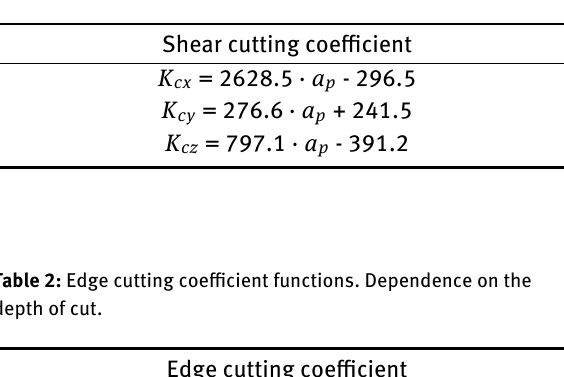
Table 1: Shear cutting coeflcient functions. Dependence on the depth of cut.